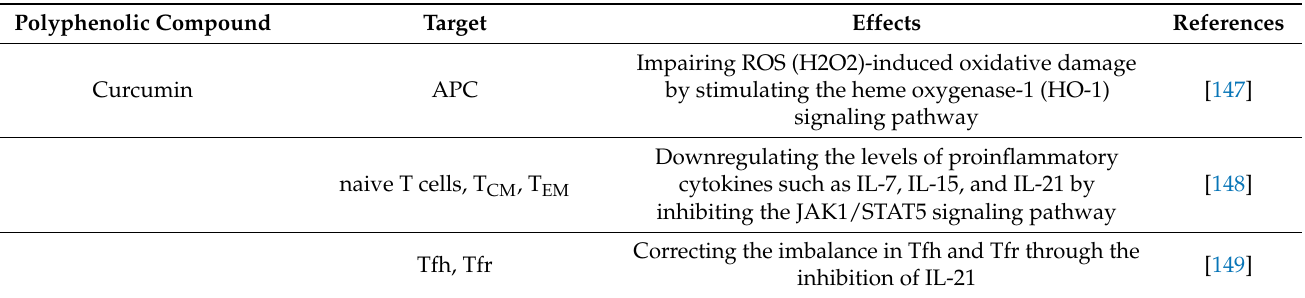
Table 2. Polyphenols regulate the immune response and oxidative stress in